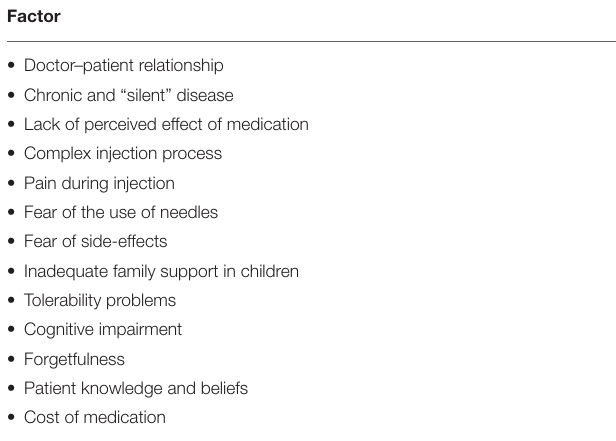
TABLE 1 | Factors that can contribute to therapeutic non-adherence in patients treated with growth hormone (1, 3).